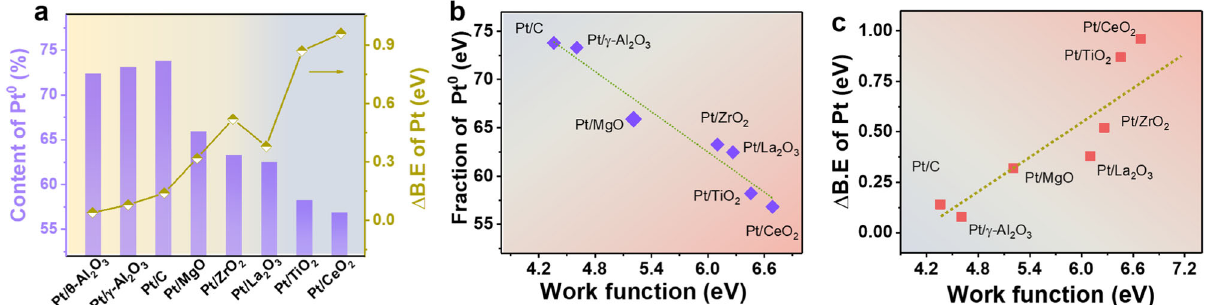
Fig. 2 Electronic properties of platinum-based catalysts. a The fraction of Pt 0 and the relative deviation of the standard binding energy of Pt 4 d (or 4 f ) on different supported catalysts. Plot of the Pt 0 content ( b ) and Δ B . E Pt ( c ) for ~2.6 nm Pt-based catalysts against the W f value of various supports,